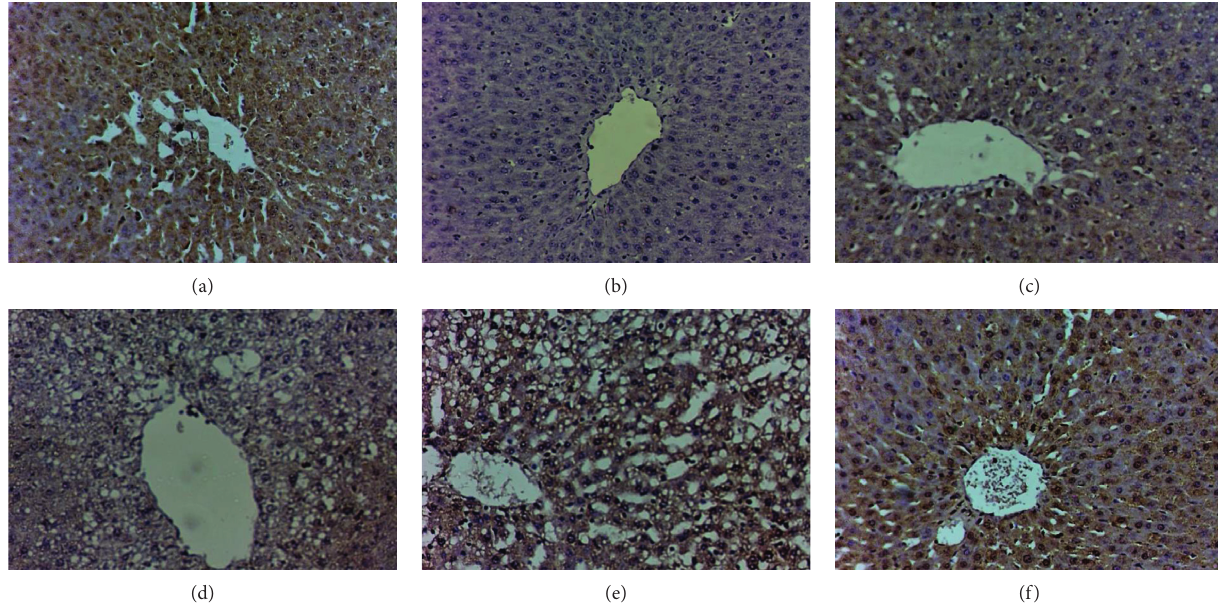
Figure 6: Effect of D. salina on hepatic expression of Bcl-2 in albino rats with age-related hepatic steatosis. Age-related hepatic steatosis was induced in rats by injections of D-galactose (200mg/kg I.P) for eight weeks. Rats injected with oral D-galactose for two weeks were treated with BDS (450mg/kg), PDS (30mg/kg), CDS (30mg/kg), or ZH (250 μ g/kg). Twenty-four hours later, the last dose of the treatment, rats were sacrificed and the liver tissue was isolated and fixed with 10% formalin for histopathological examination (100x magnification).